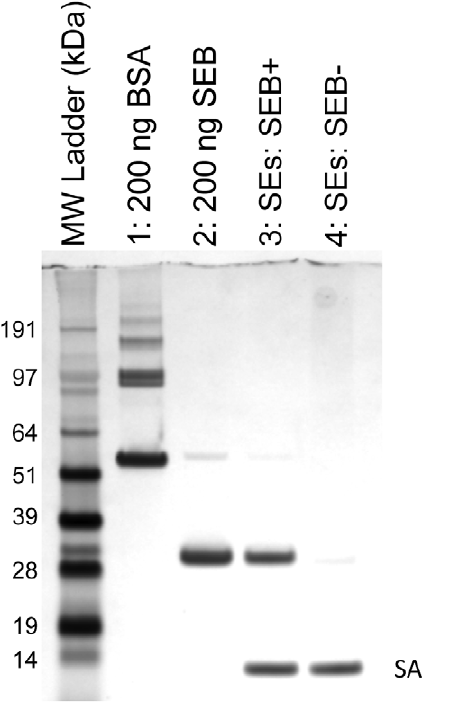
Figure 2. APT SEB1 is selective for SEB but not other closely related enterotoxins. Aptamer-precipitation of SEB from a mixture of enterotoxins was visualized by 4–12% SDS-PAGE with silver stain. Dynabeads H M-270 Streptavidin magnetic beads coated with APT SEB1 were incubated in 1000 m l PBS-T incurred with 1 m g each of SEA, SEC 1 , SEC 2 , SEC 3 , SED, and SEE. The aptamer-precipitation was carried out either with (lane 3) or without (lane 4) 1 m g SEB present in the mixture. After washing the Dynabeads with PBS-T, the protein eluate (lanes 3–8) was loaded onto the SDS-PAGE gel. Lanes 1 and 2 contain 200 ng of standard BSA and SEB, respectively. The protein bands labeled as ‘‘SA’’ represent the monomer of streptavidin liberated by the elution protocol.